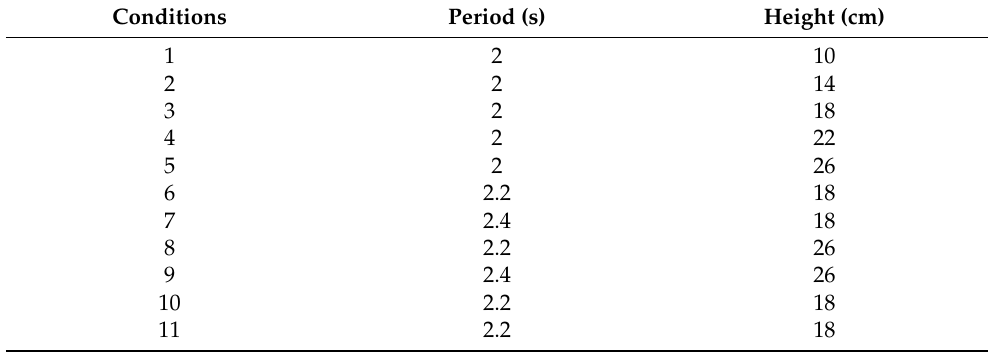
Table 2. Parameter settings of the generated waves.